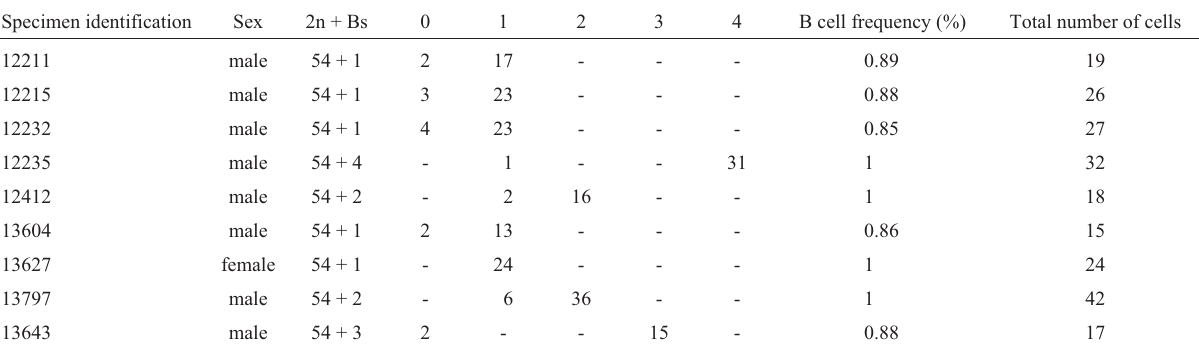
Table 2 - Distribution of B chromosomes in specimens of Cyphocharax modestus from the Paranapanema River. Specimen